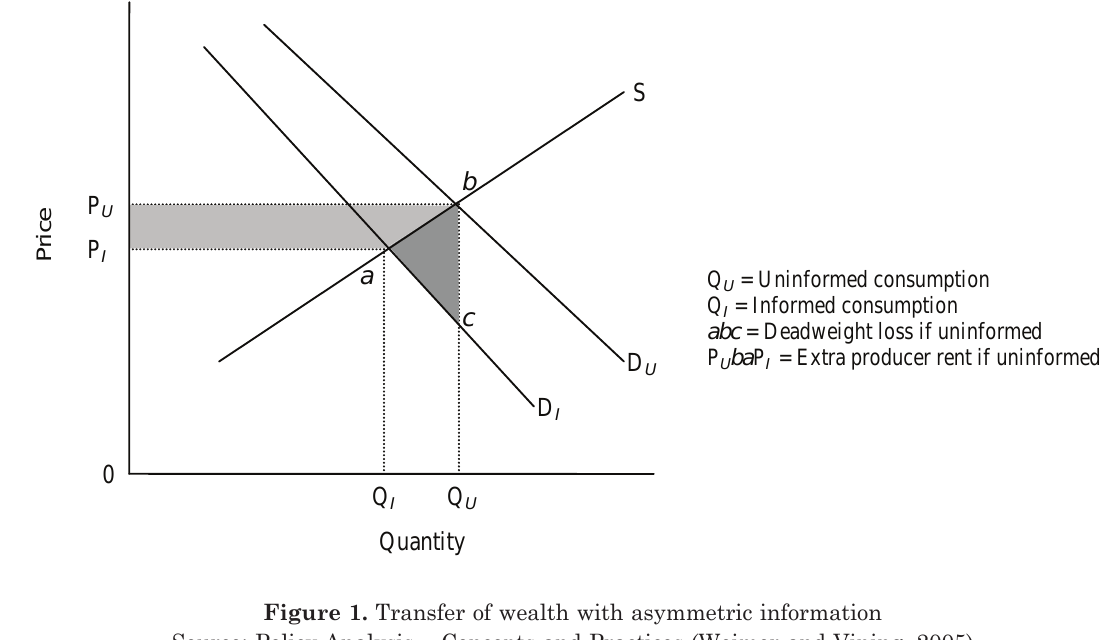
Figure 1. transfer of wealth with asymmetric information source: Policy Analysis – concepts and Practices (weimer and Vining,